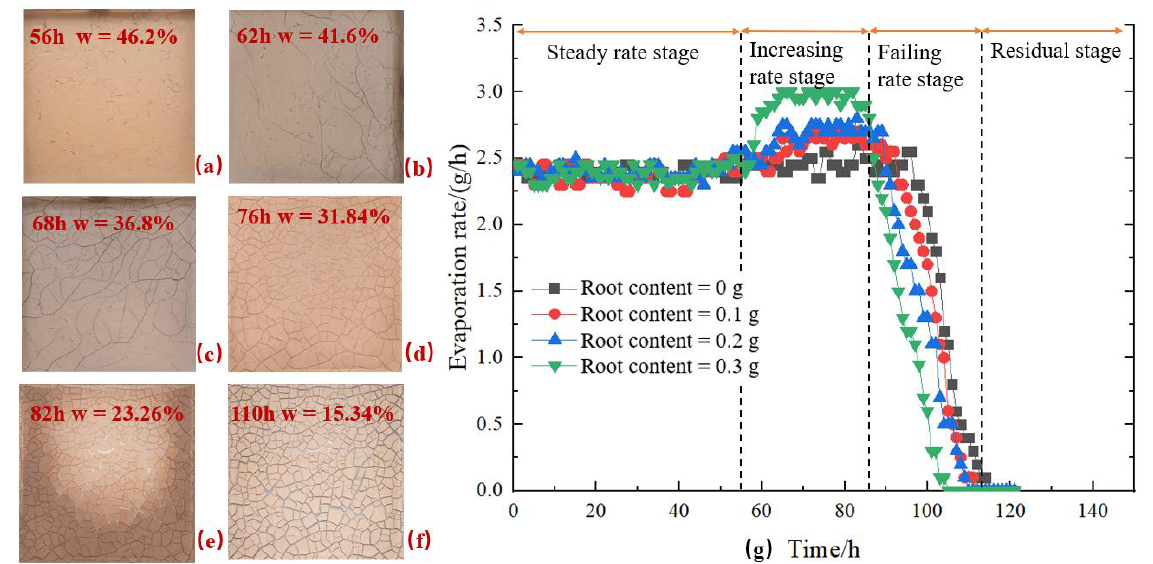
Figure 10. ( a – f ) Development process of surface fissure with root content of 0.3 g over time and ( g ) change in evaporation rate with time under different root content.